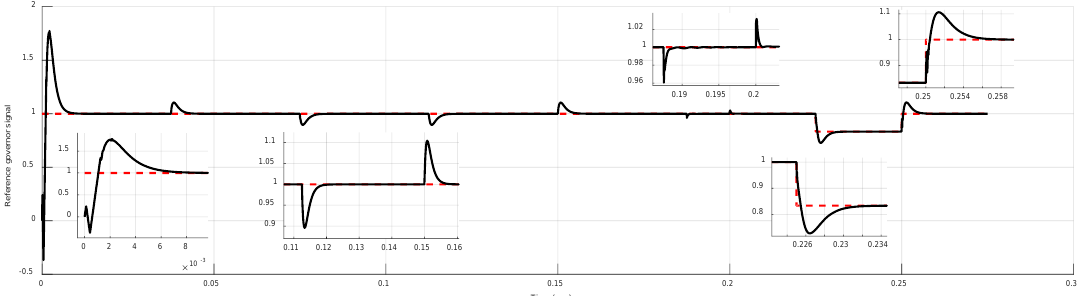
Figure 5. Reference governor signal (normalized to 1) corresponding to the cases in Figure 1. Zoomed pictures of the waveforms are given above or below, where appropriate, to improve visibility.